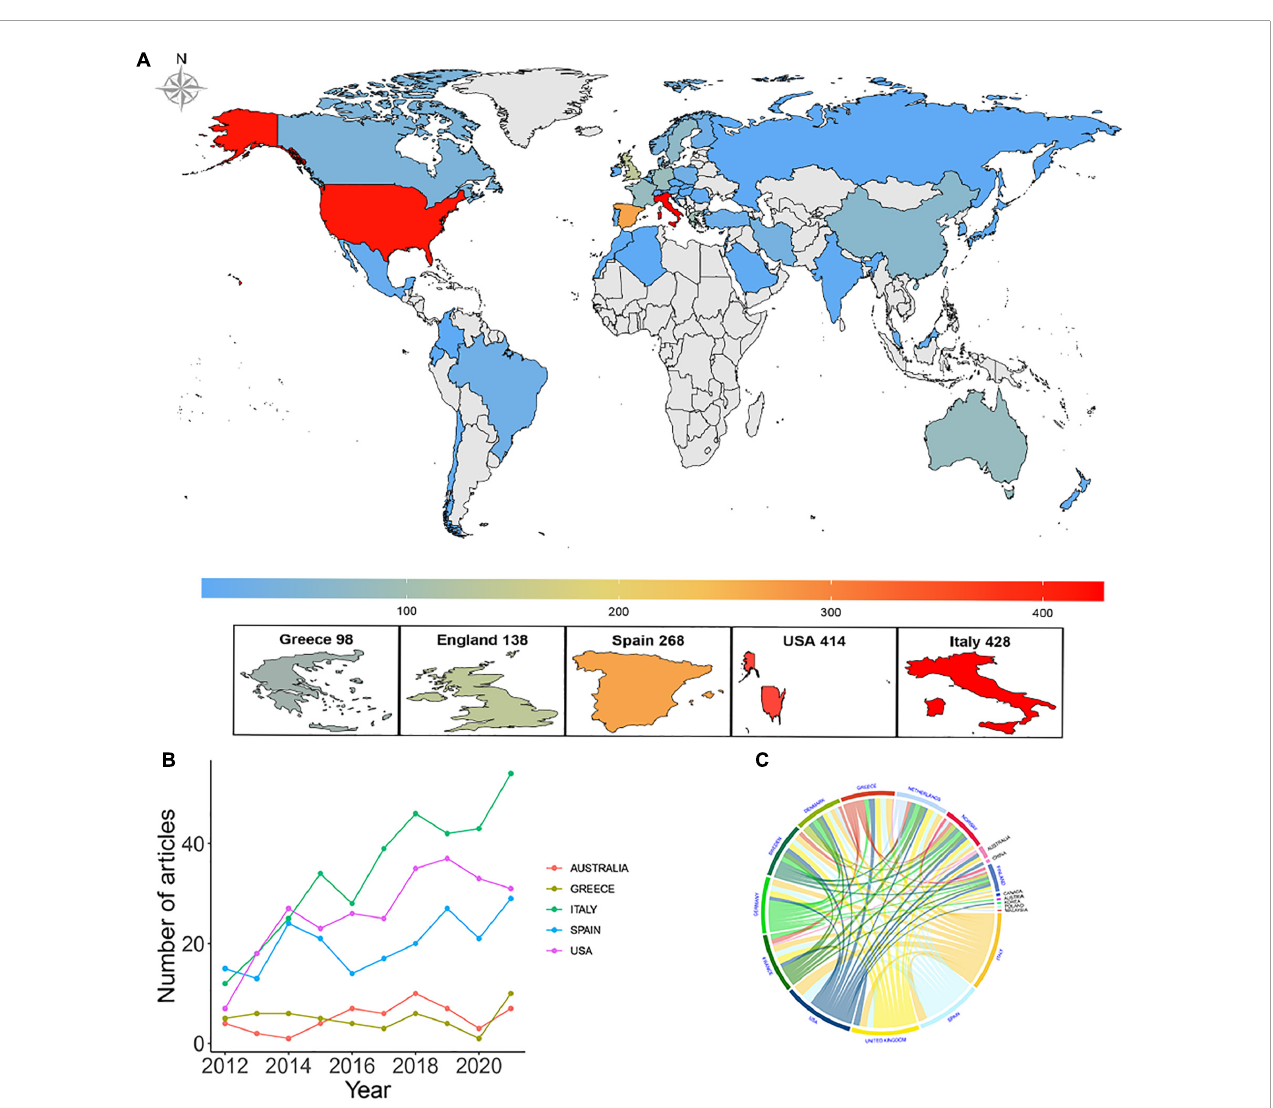
FIGURE3 (A) Geographical distribution of the countries/regions in terms of publications. (B) The trends of publications by top five countries from 2012 to 2021. (C) The chord diagram of cooperation among countries/regions.